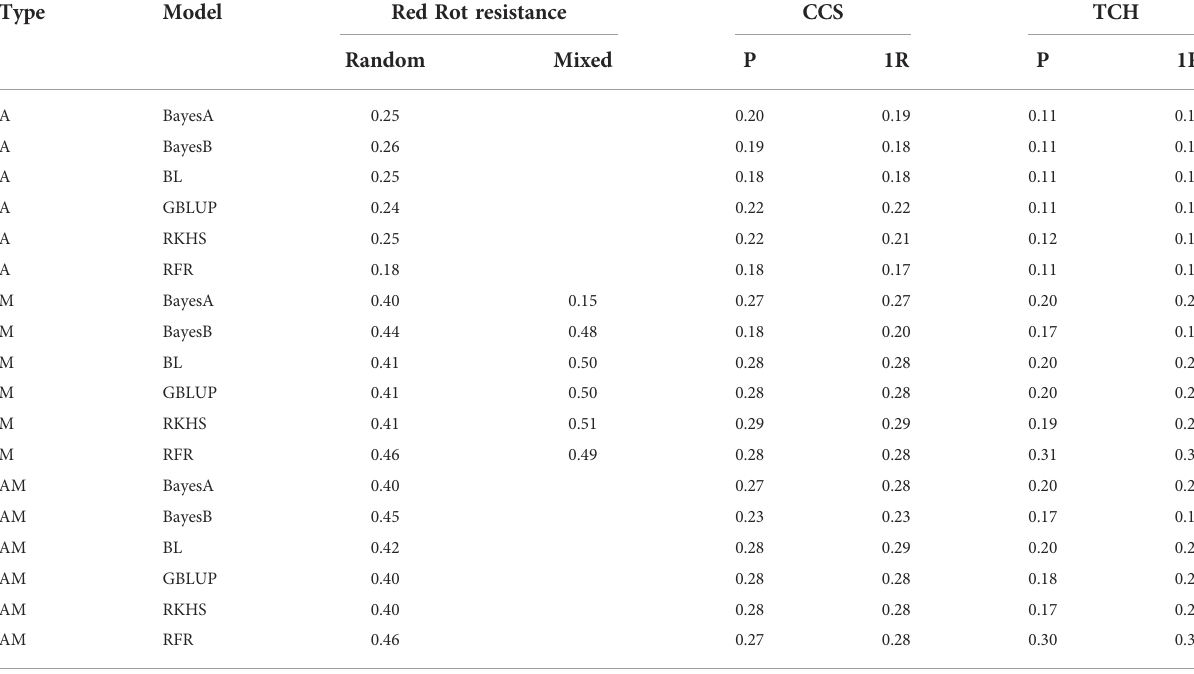
TABLE 3 Genomic prediction accuracies per type, per model, per crop class and per trait.